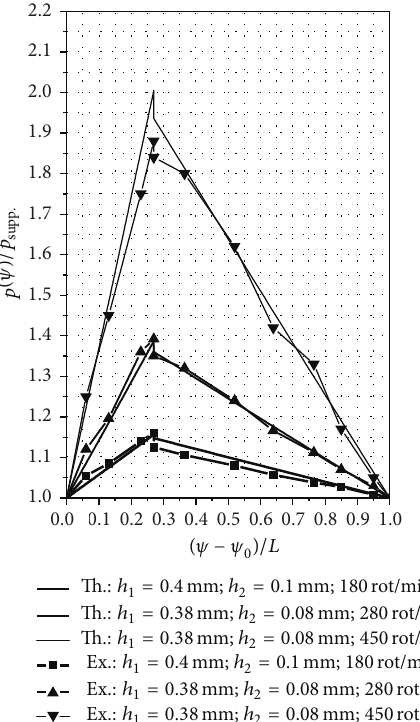
Figure 10: Pressure distributions in the SATBESPIG with inner pumping (comparison between the theoretical and experimental curves). The marked points are those where we performed the experimental